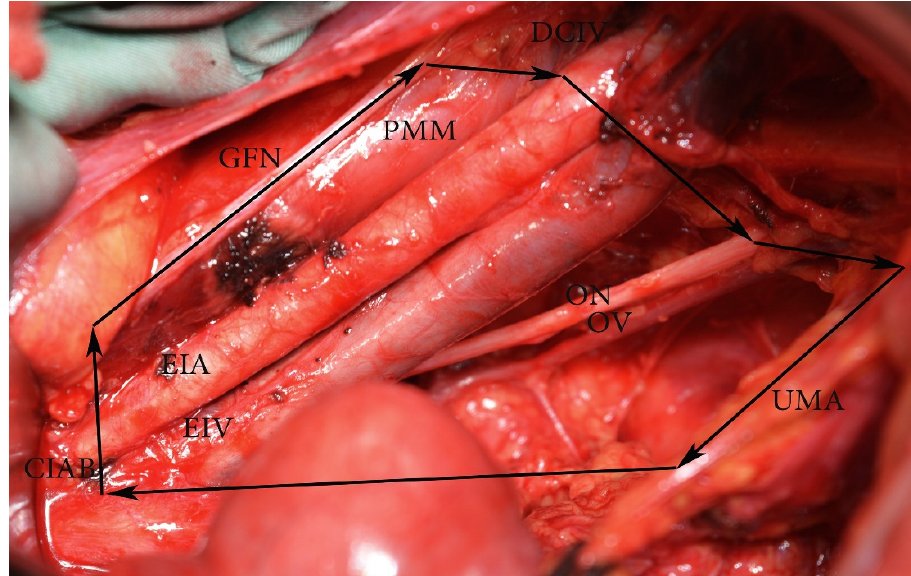
Figure 5. External and internal iliac lymph nodes dissection—anatomic boundaries (open surgery left pelvic sidewall). CIAB—common iliac artery bifurcation, ON—obturator nerve, DCIV—deep circumflex iliac vein, GFN—genitofemoral nerve, PMM—psoas major muscle, EIA—external iliac artery, EIV—external iliac vein, OV—obturator vein. The medial border is the ureter dorsally and obliterated umbilical artery ventrally. In the figure, the ureter is stretched medially for better exposure of the visible structures.